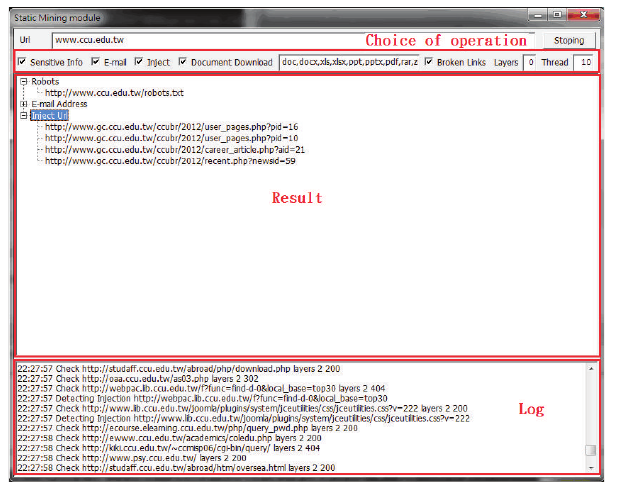
Figure 5: Static mining module. Figure 6: E-mail address leak from the website.